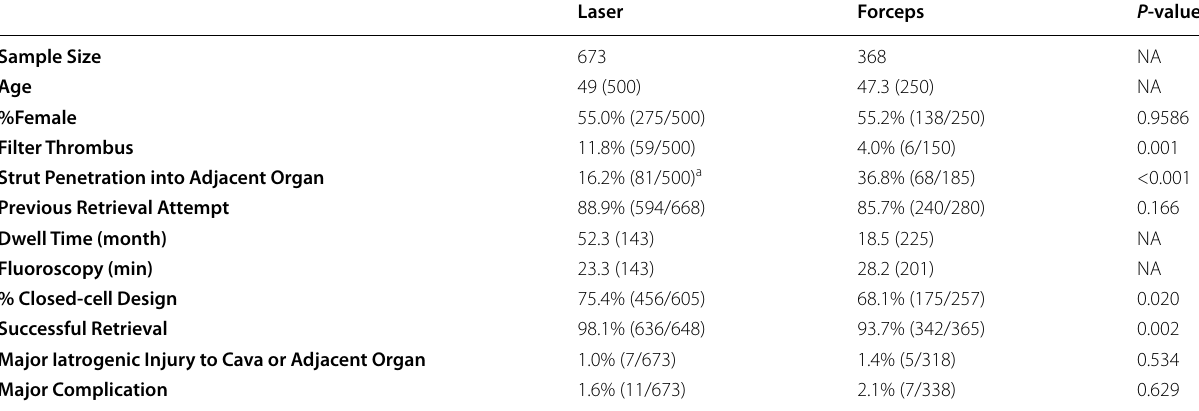
Parentheses indicate included patient sample size of selected parameter NA Not applicable a Symptomatic cases from strut penetration into adjacent organs